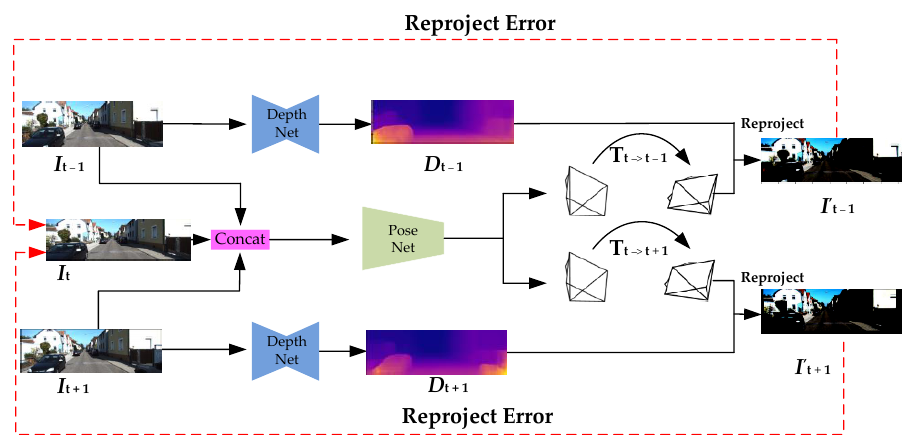
Figure 4. Illustration of our proposed learning framework for depth and pose estimation. Given a set of unlabeled video sequences, our method can estimate the depth map. Images I t-1 and I t+1 are fed to two weight – sharing frameworks consisting of a depth network for depth map calculation.